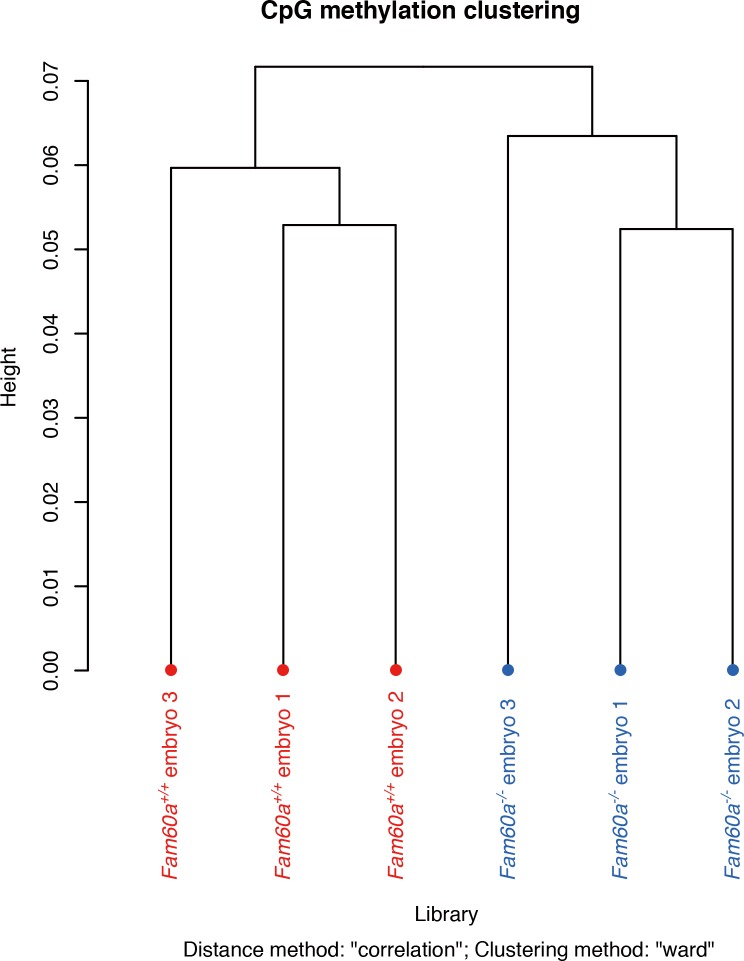
Genome-wide DNA methylation profiles of Fam60a–/– and WT embryos at E9.5.Dendrogram of hierarchical clustering analysis for samples based on the similarity of their methylation profiles.